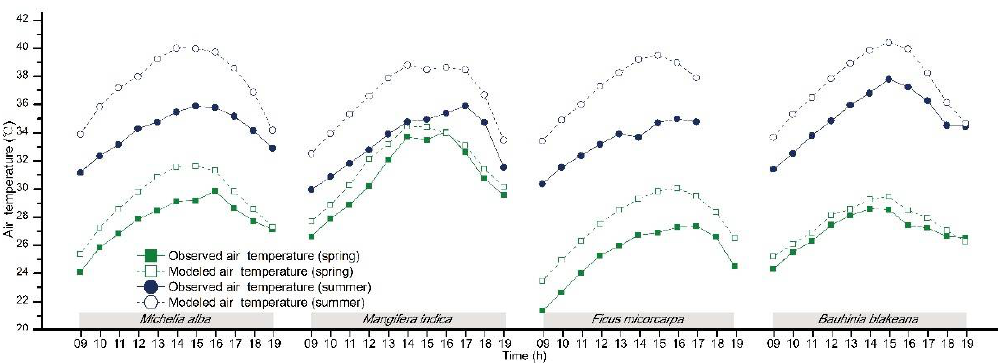
Figure 8. Comparison of modeled and observed air temperatures in canopy shade areas.